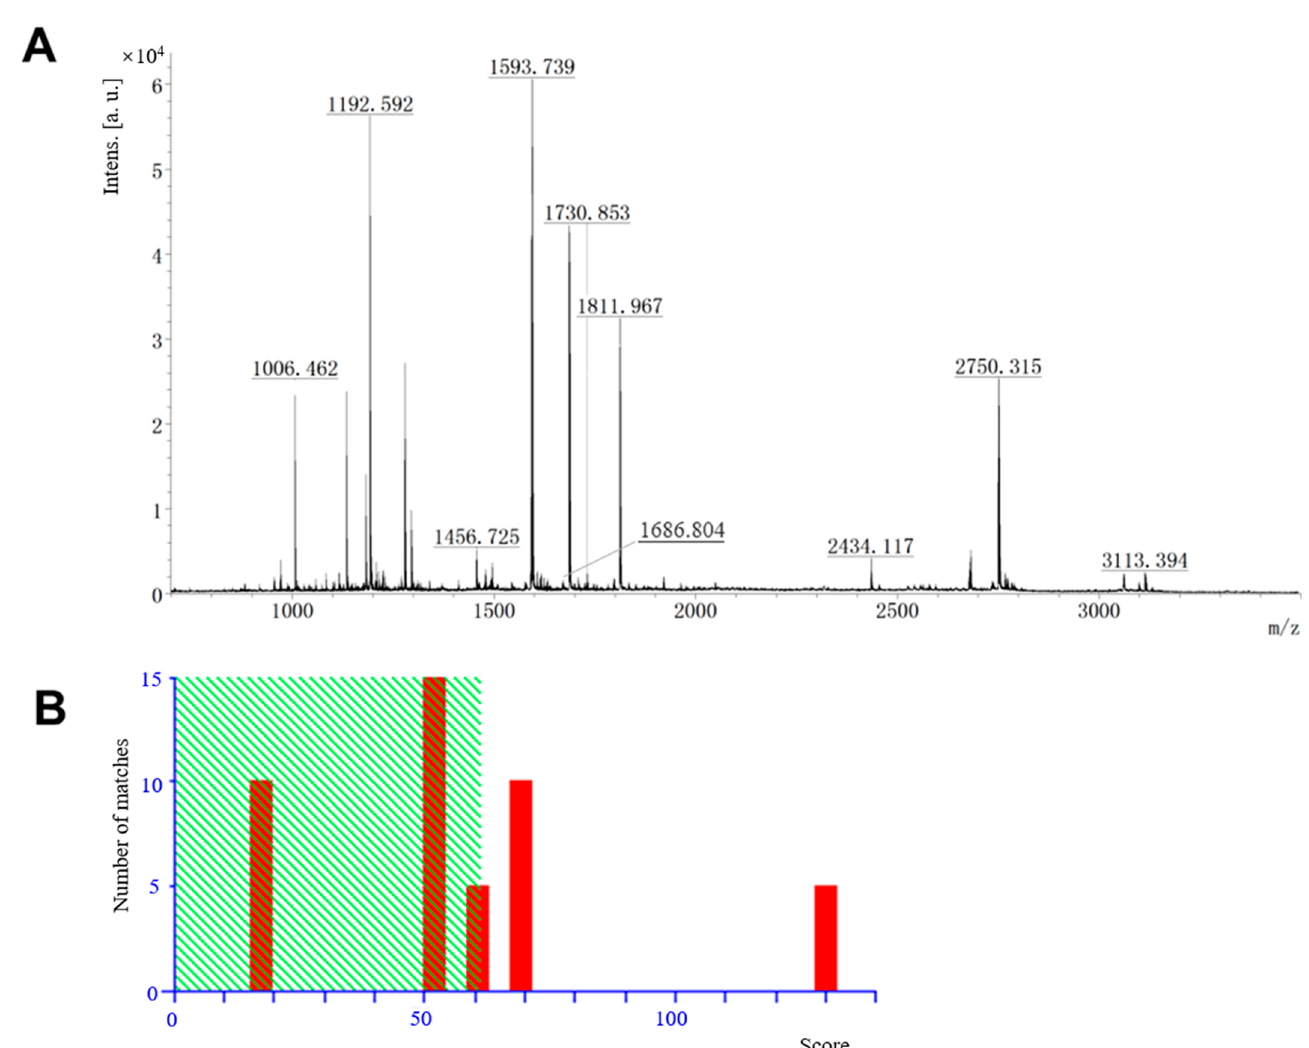
Figure 8. Mass spectrogram of PF-2-2 by MALDI-TOF/TOF-MS ( A ) and peptide score distribution ( B ). Ion score is − 10log(P), where P is the probability of the observed match (a random event). There are 3 peptide matches above identity threshold and 5 matches above homology threshold for 10 queries. Individual ions scores of peptides > 61 (beyond green shading) indicate identity or extensive homology ( p < 0.05). Table 2. Amino acid sequence of Low molecular mass 30 kDa lipoprotein 21G1.